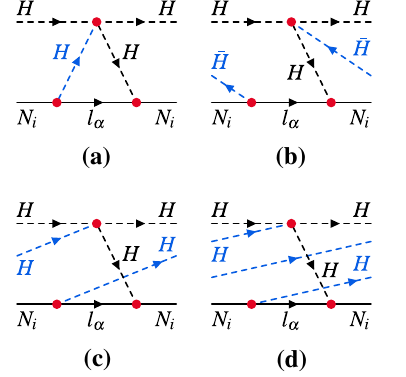
Fig. 2 Forward scattering processes representing the contribution of the Higgs thermal propagator expanded into infinite series of zero- temperature